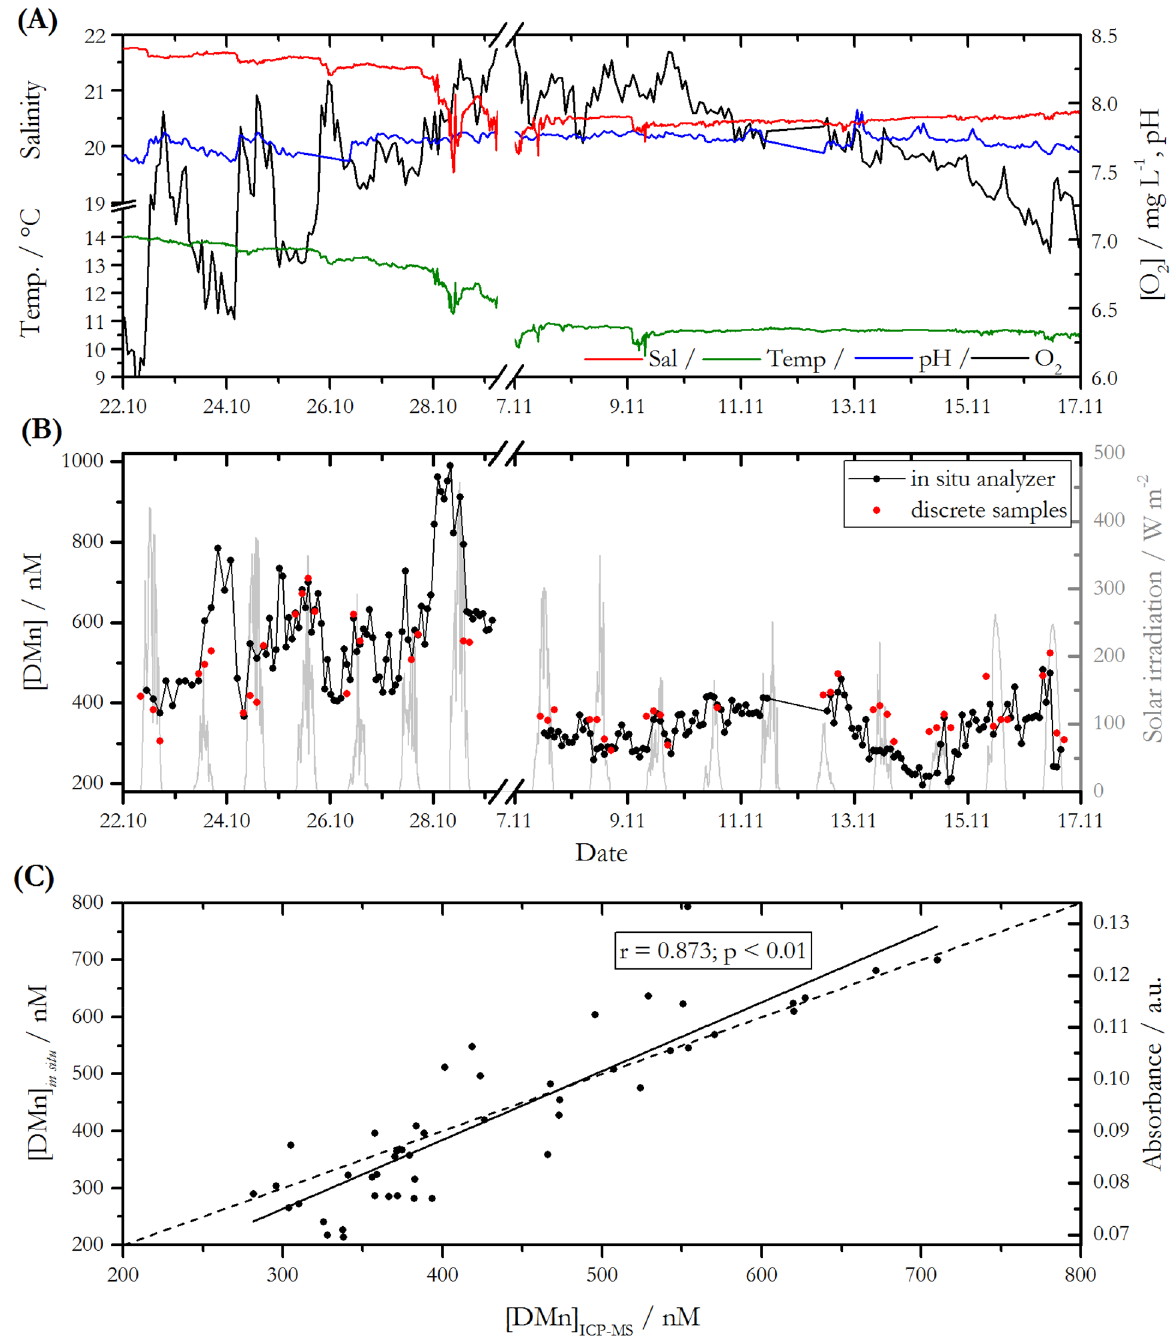
Figure 5. Time series for the periods October 22 to 29, 2018, and November 07 to 17, 2018, of ( A ) in situ determined hydrographic data and ( B ) DMn time series determined with in situ LoC analyser (black) and from discrete samples analysed via ICP-MS (red). ( C ) Scatter plot of in situ absorbance and DMn concentration vs. ICP-MS analysis (linear fit: [DMn] in situ = 1.207 ⋅ [DMn] ICP-MS – 98.310; Spearman correlation parameters: r = 0.873, p = 1.3 ⋅ 10 –15 , n = 47); y = x (dashed line) is also displayed for conditions was observed over the same time period. During the period of the deployment, mean pH values of 7.74 ± 0.10 and oxygen concentrations of 7.9 ± 0.9 mg ⋅ L −1 were observed. Analysis of discrete samples for nitrate, phosphate and DOC showed mean concentrations of 2.1 ± 0.7 µM, 1.3 ± 0.1 µM and 257 ± 15 µM, respectively, over the time period October 22 to November 17, 2018. Performance evaluation of the analyser. During the period October 29 to November 7 the system underper- formed, producing unreliable data for both the on-board standard solutions and the natural water samples,